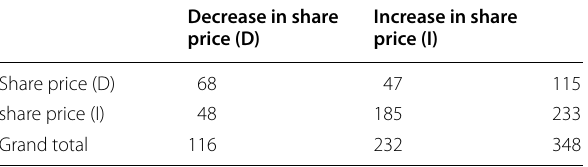
Table 3 Number of monthly share price movement of the second-tier market of NSE. Source: Authors computation